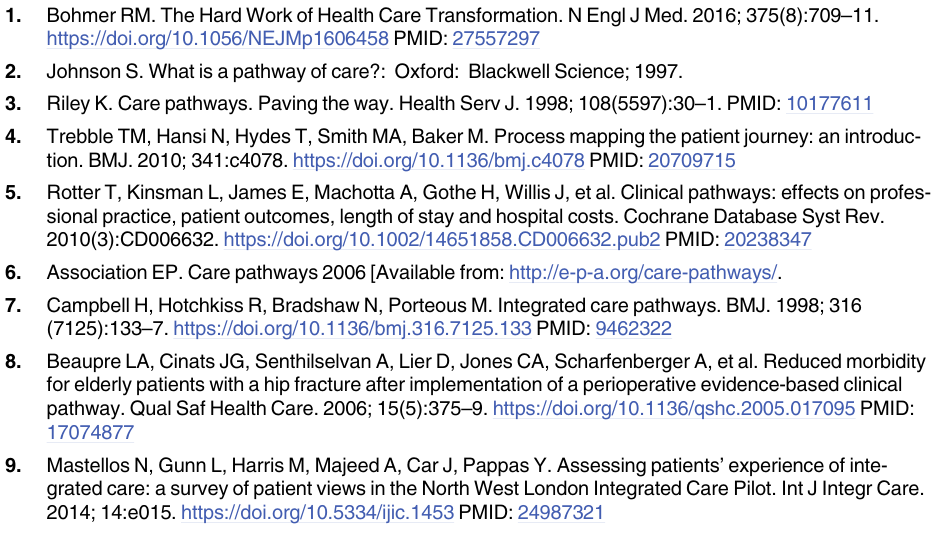
S1 Table. Full search phrases used for the three respective databases. S2 Table. Inclusion and exclusion criteria used to select studies for the review. S3 Table. Joanna Briggs Institute quality assessment checklist for cohort studies. S4 Table. Joanna Briggs Institute quality assessment checklist for case